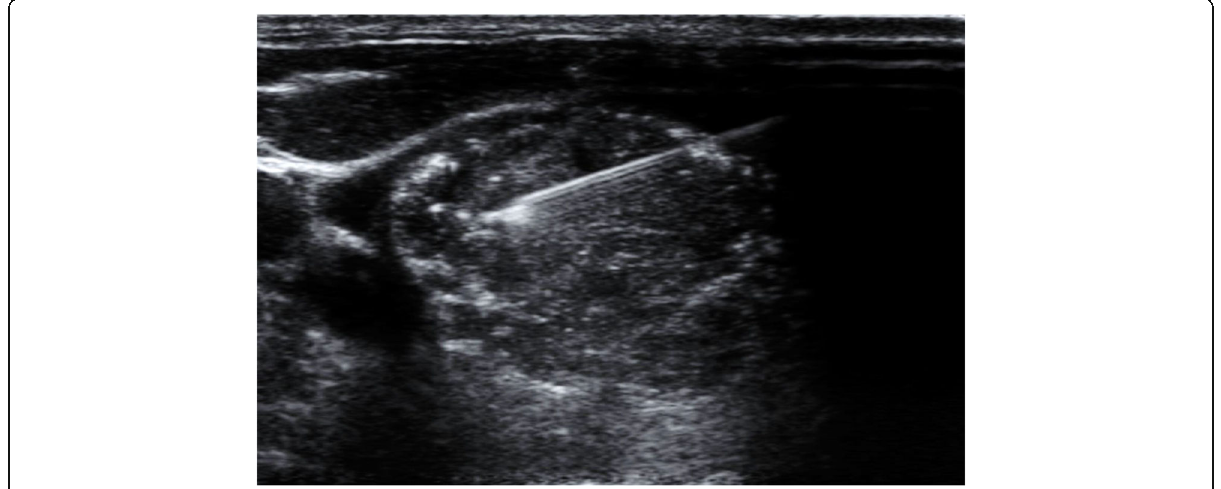
Fig. 2 The ultrasound-guided fine-needle aspiration from a hypoechoic solid nodule with more than 5 punctate echogenic foci in the right thyroid lobe of a 49-year-old female patient, which was proved by cytology to be a papillary thyroid